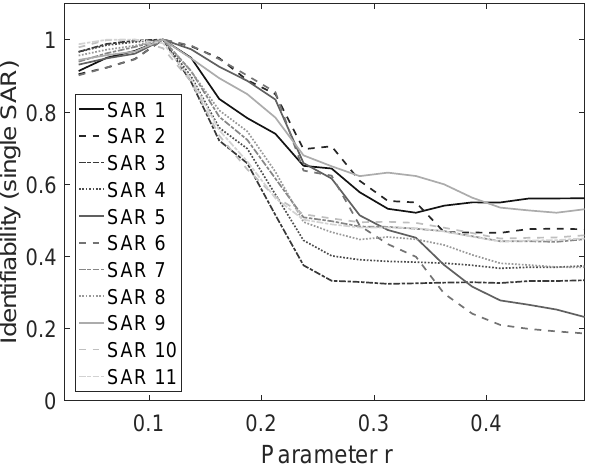
Figure 5. Identifiability against r parameter for each EN- VISAT SAR observation in our sample.